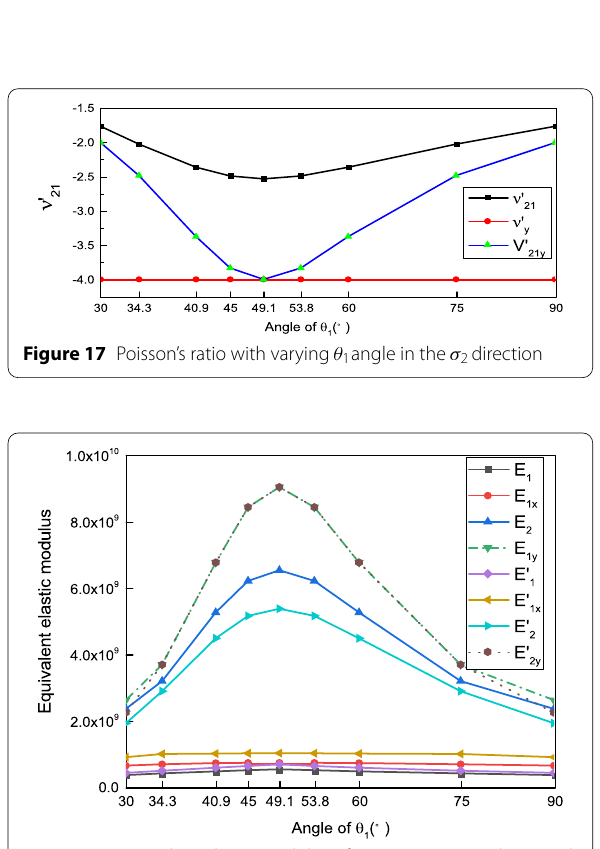
Figure 18 Equivalent elastic modulus of two structures in the σ 1 and σ 2